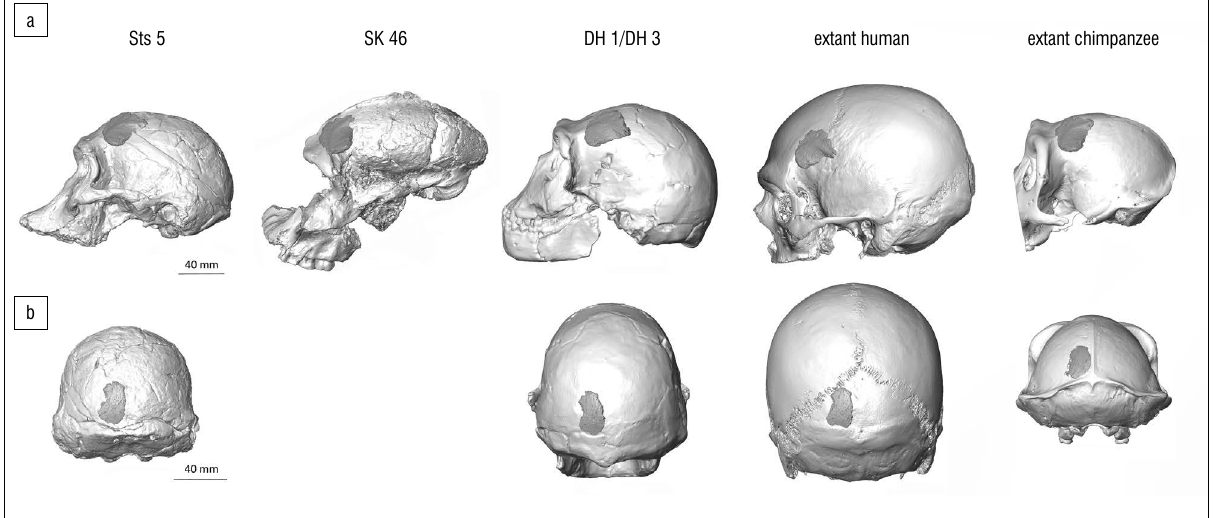
figure 3: Superimposition of (a) StW 671 (in lateral view) and (b) StW 672 (in posterior view) on the digital replicas of Sts 5 ( Australopithecus africanus ), SK 46 ( Paranthropus robustus ), DH 1/DH 3 ( Homo naledi ) and extant human and chimpanzee crania.